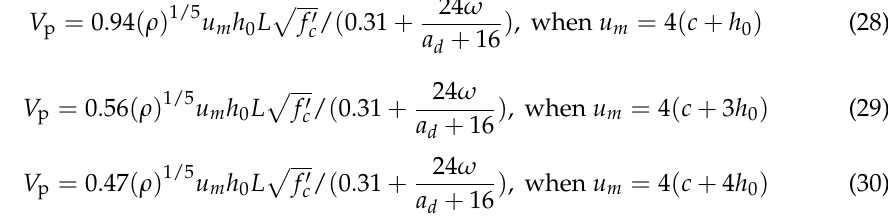
Table 4. Comparison of punching shear with different critical section perimeter.